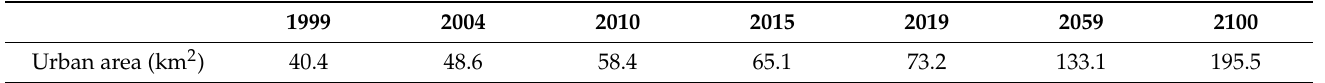
Table 9. Evolution of the Mazatlan urban